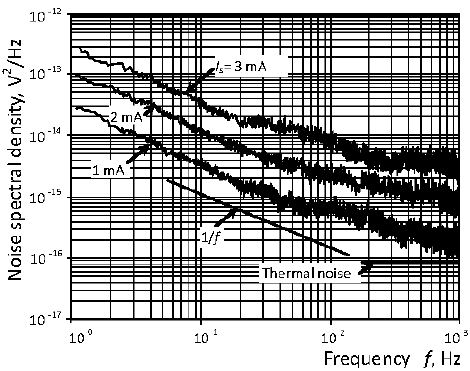
Figure 4. Power spectral density of internal noise in channel V y (0), the supply current I s is as a parameter, T = 20